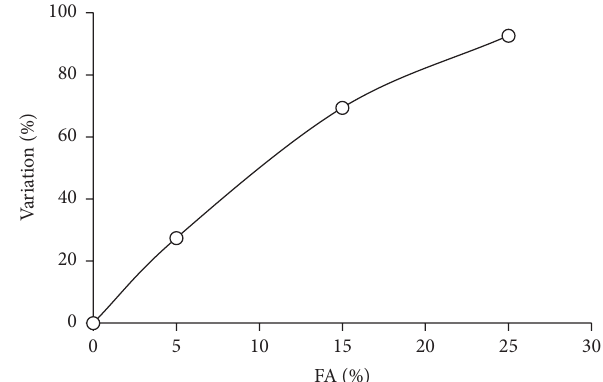
Figure 15: Free swelling variation versus the amount of FA content.